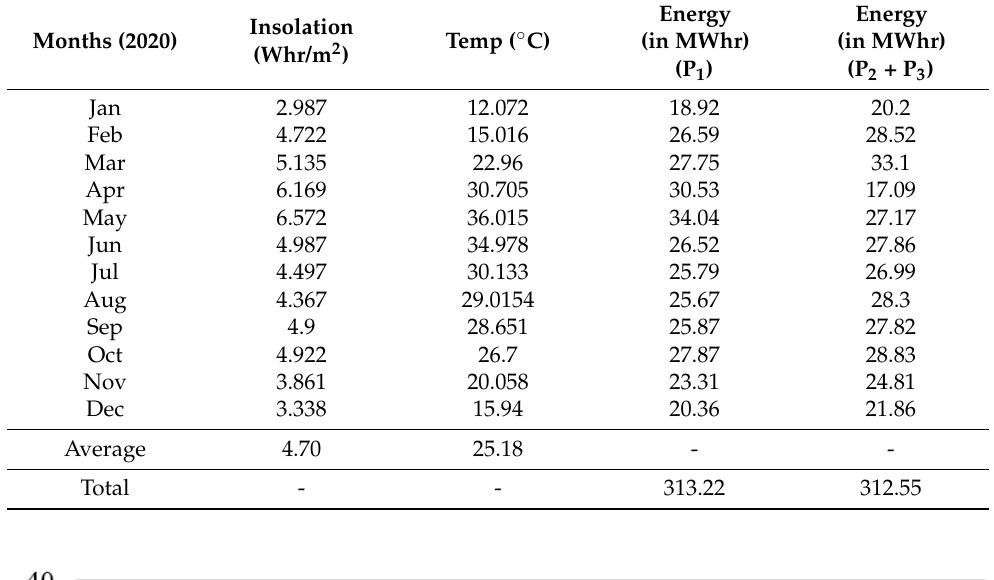
Table 7. Comparison of Generated Energy in 2020 (P 1 vs. P 2 + P 3 ).